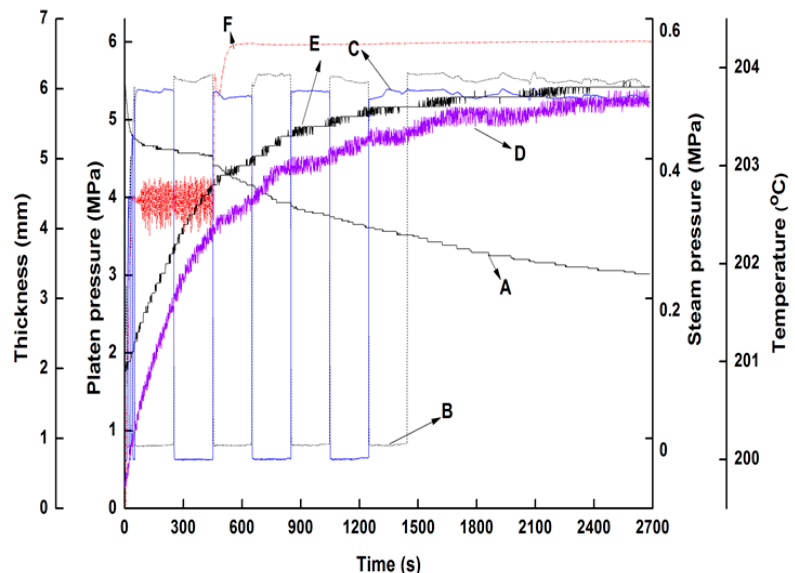
Figure 2. Thermo-hygro-mechanical densification process. A : Thickness; B , C : top and bottom platen steam pressure, respectively; D , E : top and bottom platen temperature; F : platen load.